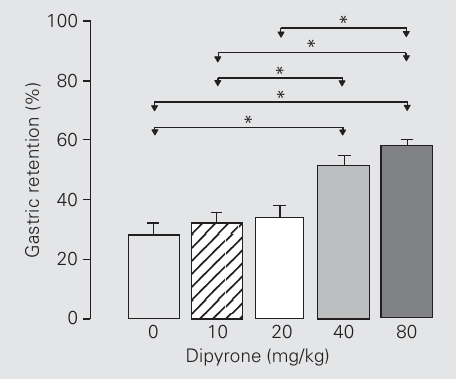
Figure 1. Gastric retention (%), reported as mean ± SEM, of a saline test meal determined 10 min after administration to rats by gavage. The animals (N = 5) received iv vehicle (0) or dipy- rone (10, 20, 40 and 80 mg/kg) 60 min before the determination of gastric retention. *P < 0.01 for the comparisons indicated by the arrows (Tukey